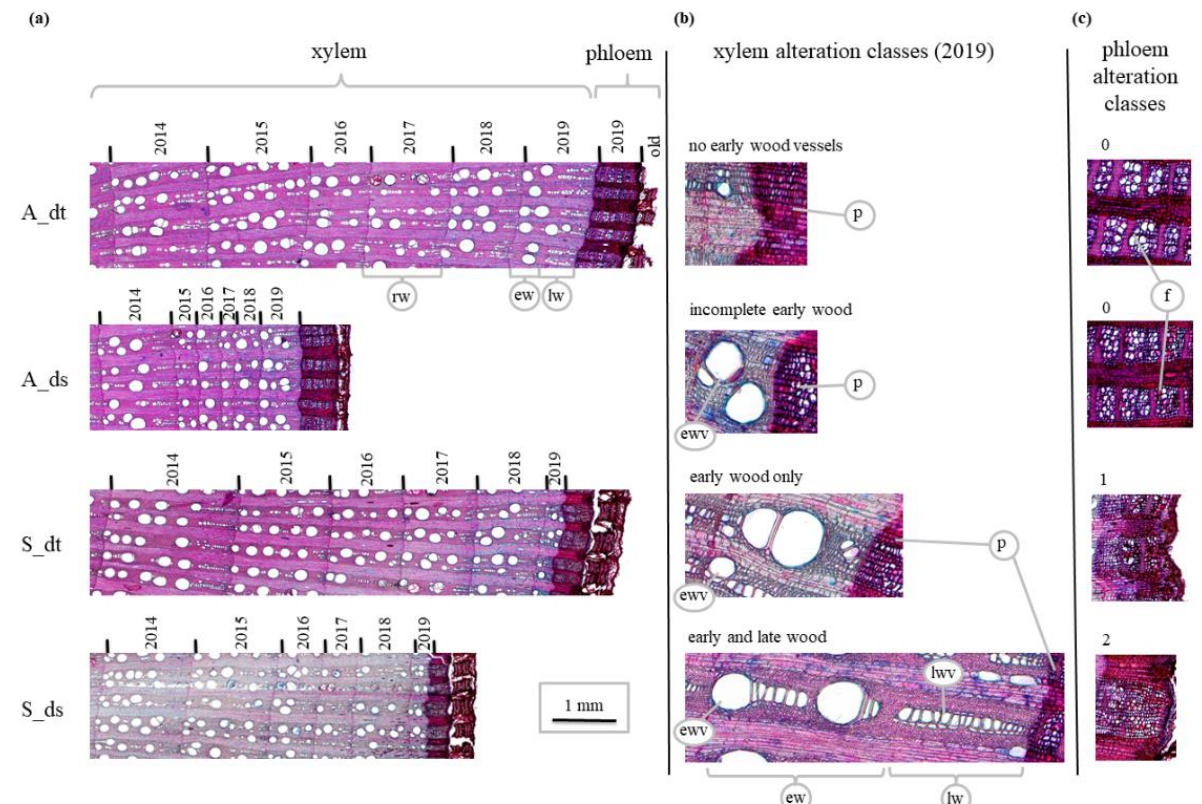
Figure 2. Anatomical structure of sections cored from grapevine’s trunk. ( a ) Selected 2014–2019 sections according to the four categories considered; ( b ) xylem tissue alteration classes in 2019; ( c ) phloem alteration classes according to the overall disarrangement and the presence of the fibre sclereids. A_dt = Asymptomatic and drought-tolerant; A_ds = Asymptomatic and drought-sensitive; S_dt = Symptomatic and drought-tolerant; S_ds = Symptomatic and drought-sensitive; rw = ring width; ew = early wood; lw = late wood; ewv = early wood vessel; lwv = late wood vessel; p = phloem; f = fibre.